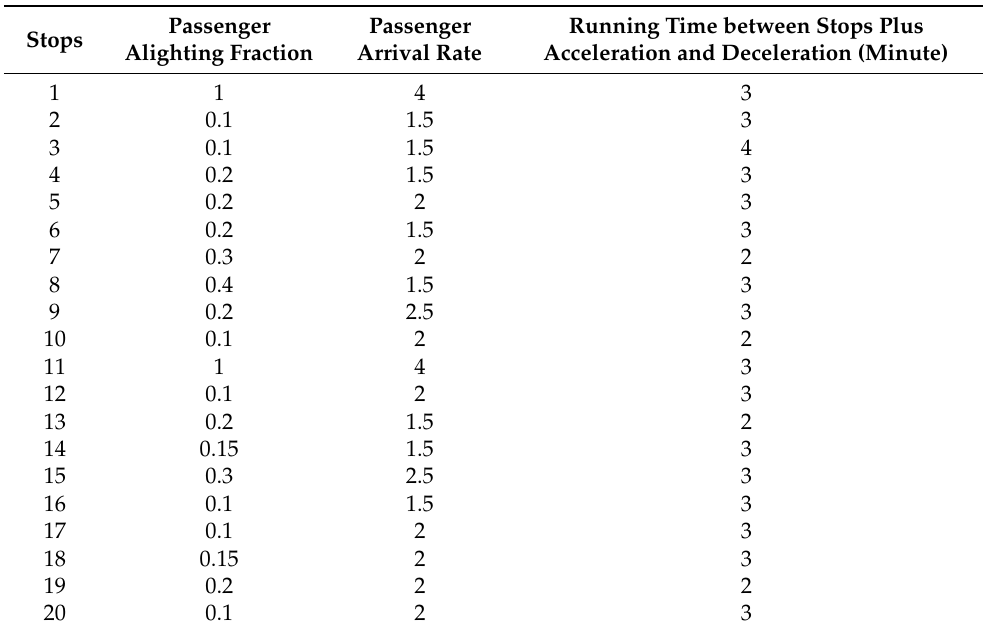
Table 2. Historical